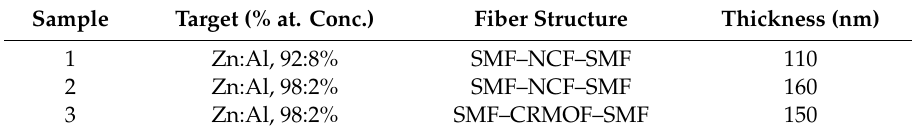
Table 1. Features of deposited aluminum-doped zinc oxide (AZO) coatings and type of fiber. Sample Target (% at. Conc.) Fiber